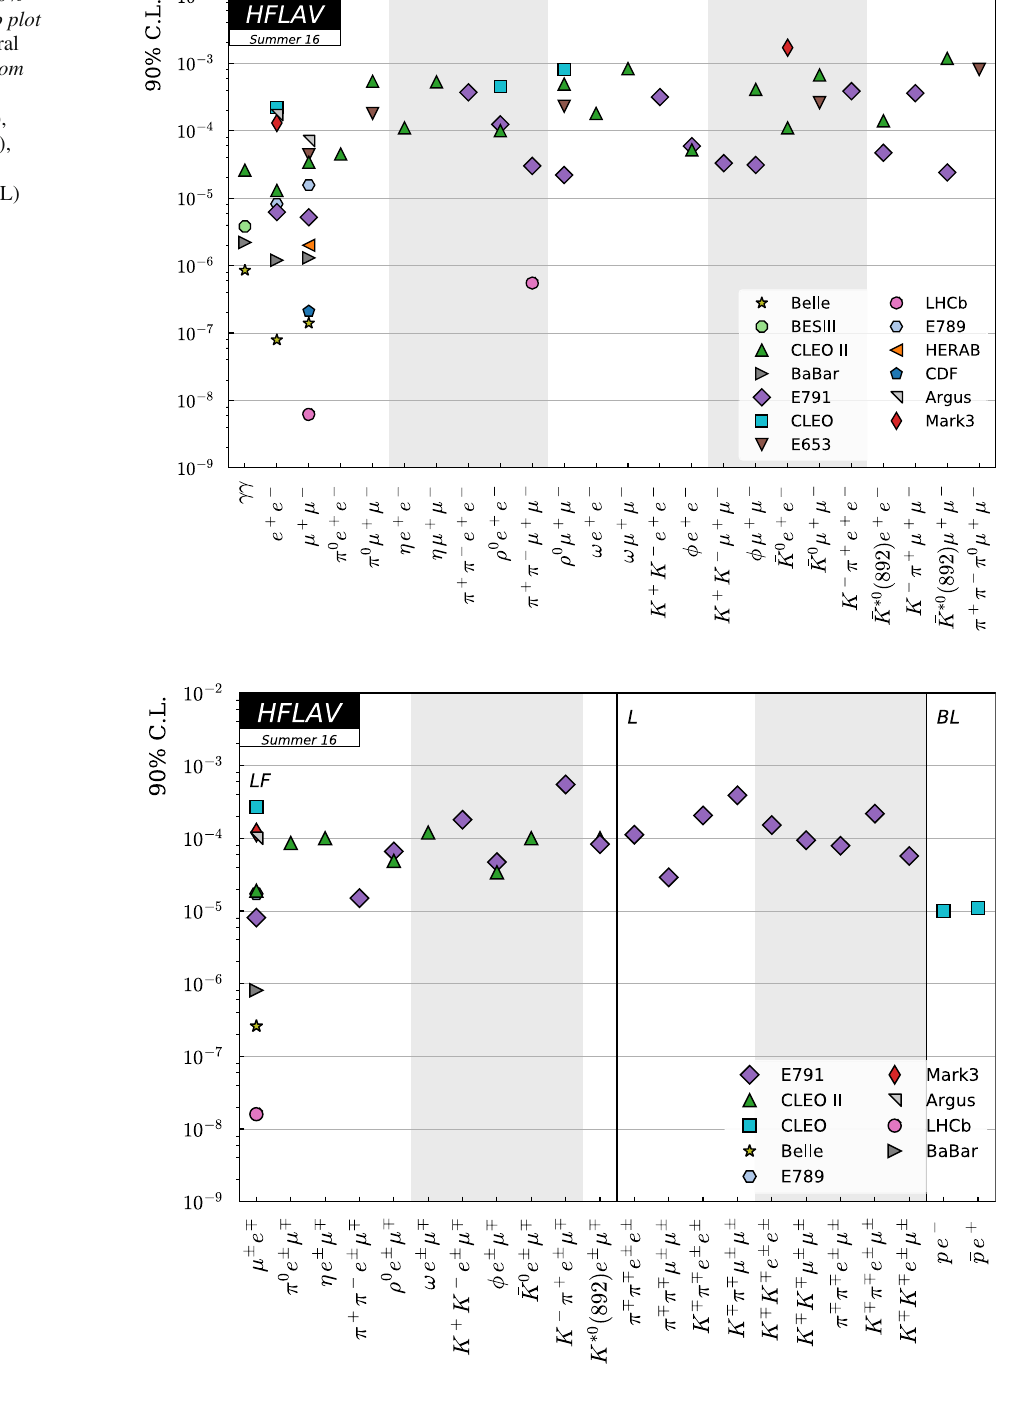
Fig. 217 Upper limits at 90% C.L. for D 0 decays. The top plot shows flavor-changing neutral current decays, and the bottom plot shows lepton-flavor-changing (LF), lepton-number-changing (L), and both baryon- and lepton-number-changing (BL)